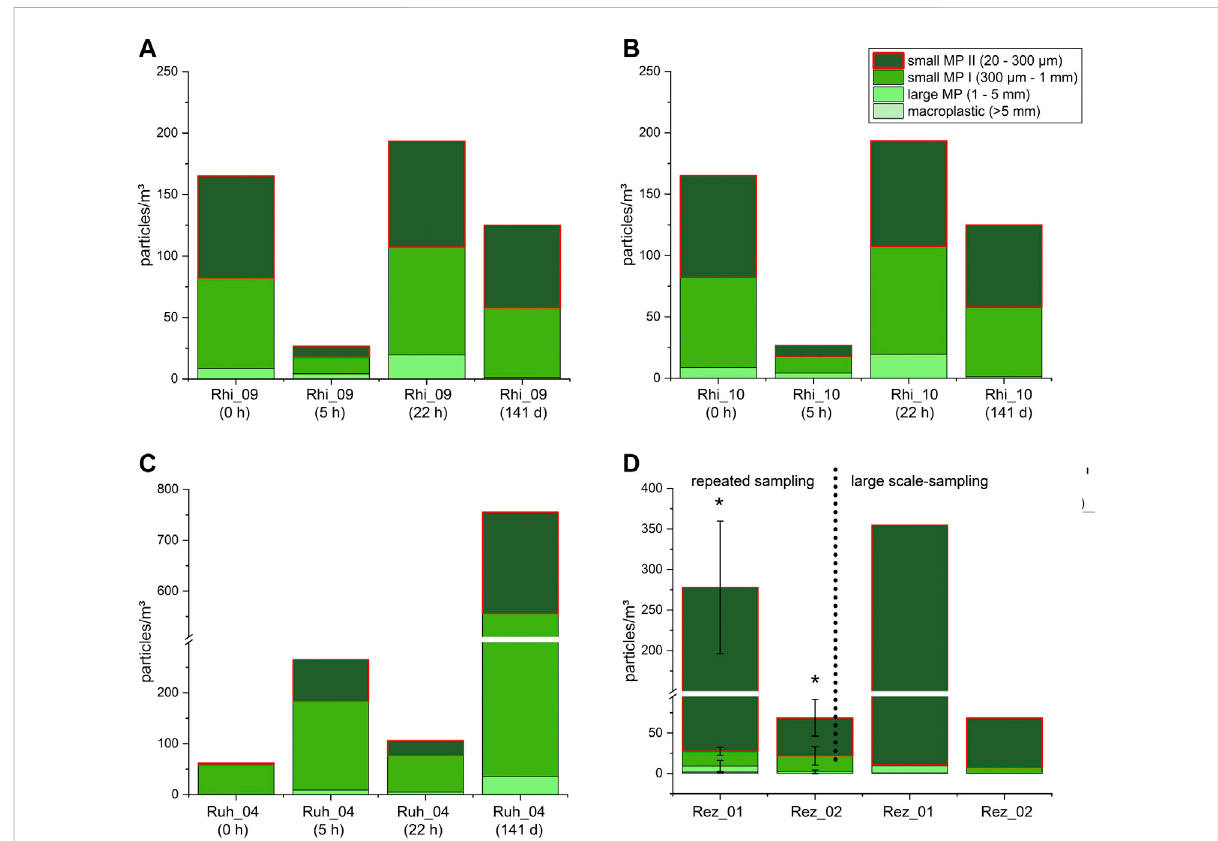
FIGURE 6 Detected MPparticle concentration (MP/m³)per sizeclassduring therepeatedsamplingsurvey. The Rhineand theRuhrriversweresampledat four different points of time (0 h, 5 h, 22 h, and 141 days): (A) Rhi_09 (upstream of the Ruhr River), (B) Rhi_10 (downstream of the Ruhr River) and (C) theRuhrRiver(Ruh_04)atthemouthoftheriver. (D) Inthesameway,theSchwäbischeRezatRiverwassampledatthreedifferentpointsoftime(0 h, 0.5 h, and 1 h) at two locations: Rez_01 (upstream of a WWTP) and Rez_02 (downstream of a WWTP) during the repeated sampling survey in 2016 (mean ± SD) and at a single time point during the large-scale sampling survey in 2015. The non-quantitatively sampled size class small MP